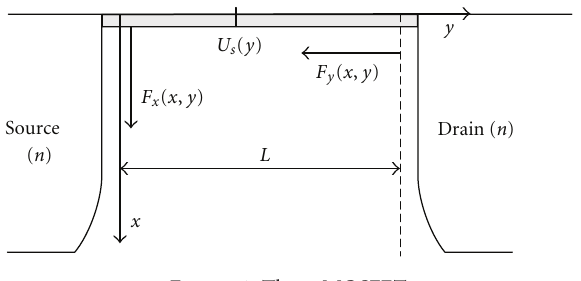
Figure 1: The n -MOSFET.